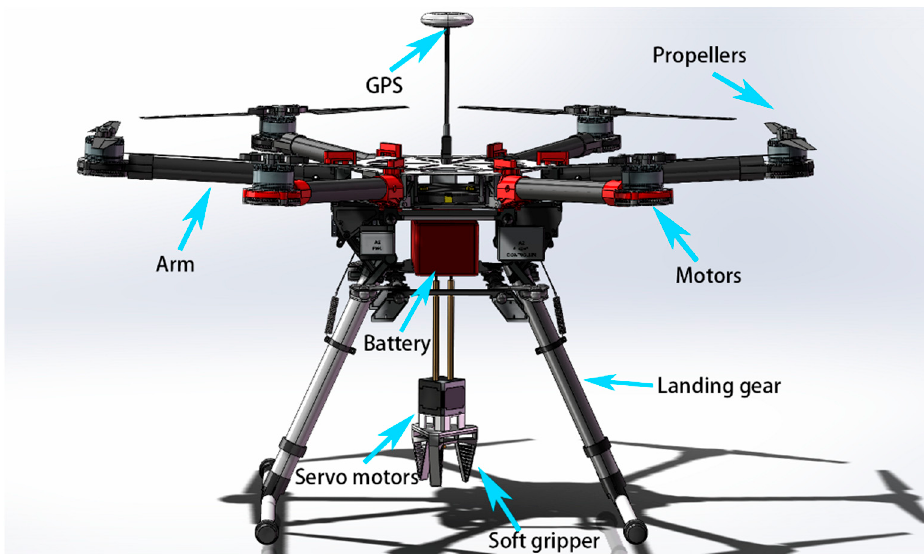
Figure 13. An intelligent delivery drone based on the proposed soft robotic gripper. Supplementary Materials: The following are available online at www.mdpi.com/xxx/s1. Video S1: Grasping demonstration of the proposed soft robotic gripper with force feedback function.